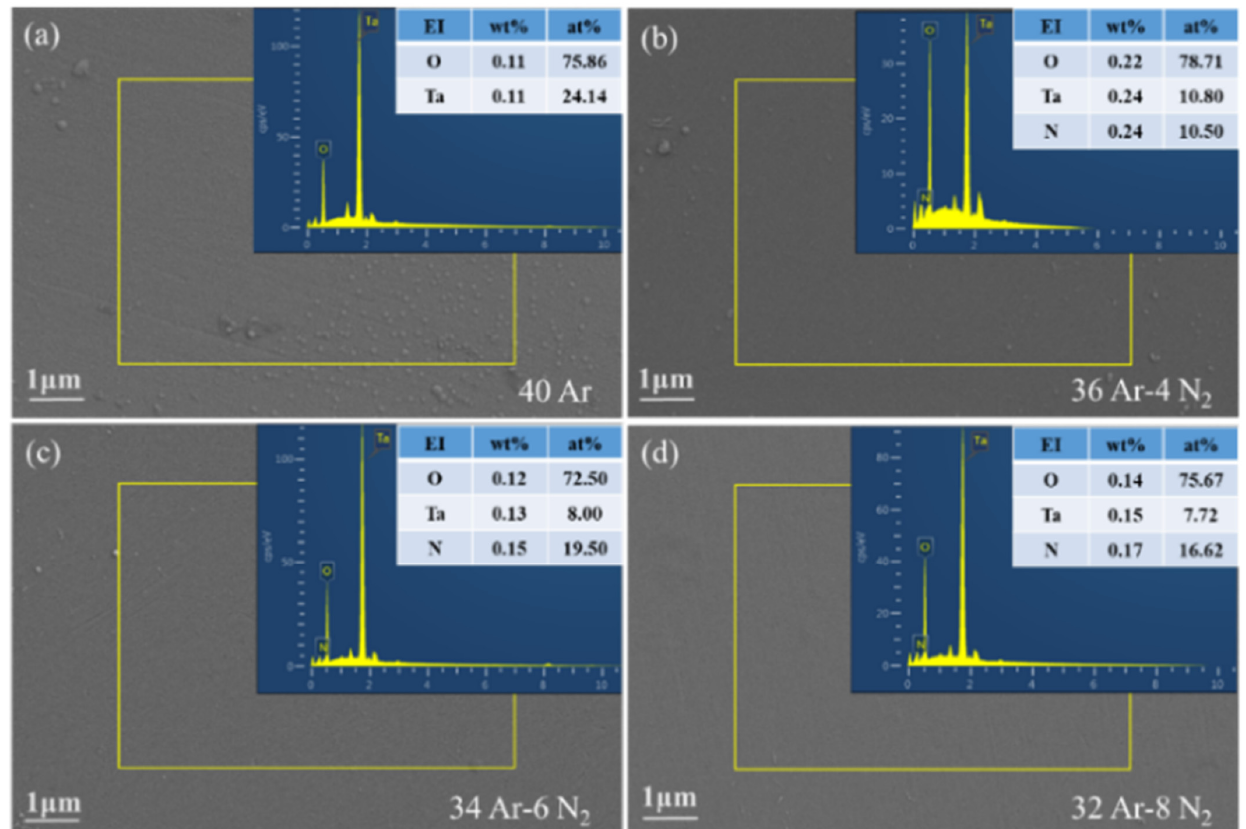
Figure 5. EDS energy spectrum of Ta 2 O 5 coatings prepared with different N 2 flow rates and a sputtering power of 140 W. ( a ) 40Ar, ( b ) 36Ar-4N 2 , ( c ) 34Ar6-N 2 , ( d ) 32Ar-8N 2 .